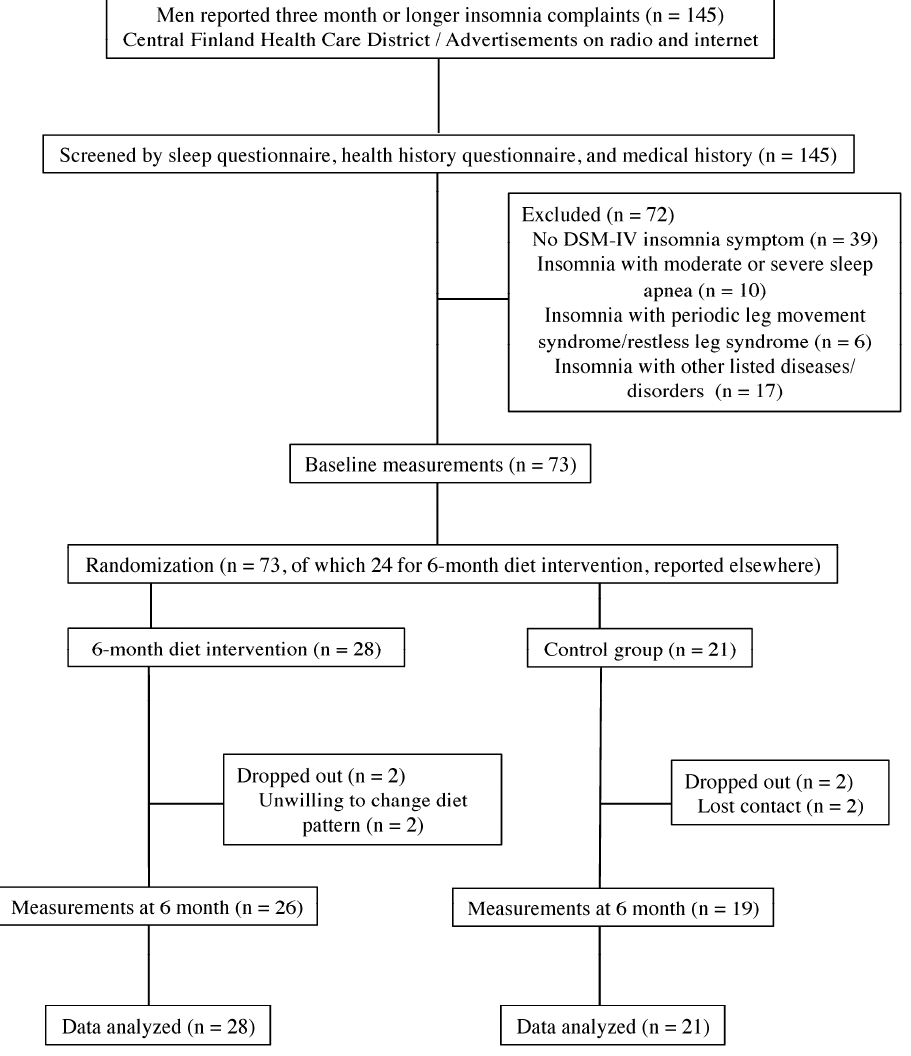
Figure 1. Participant flow of the study.